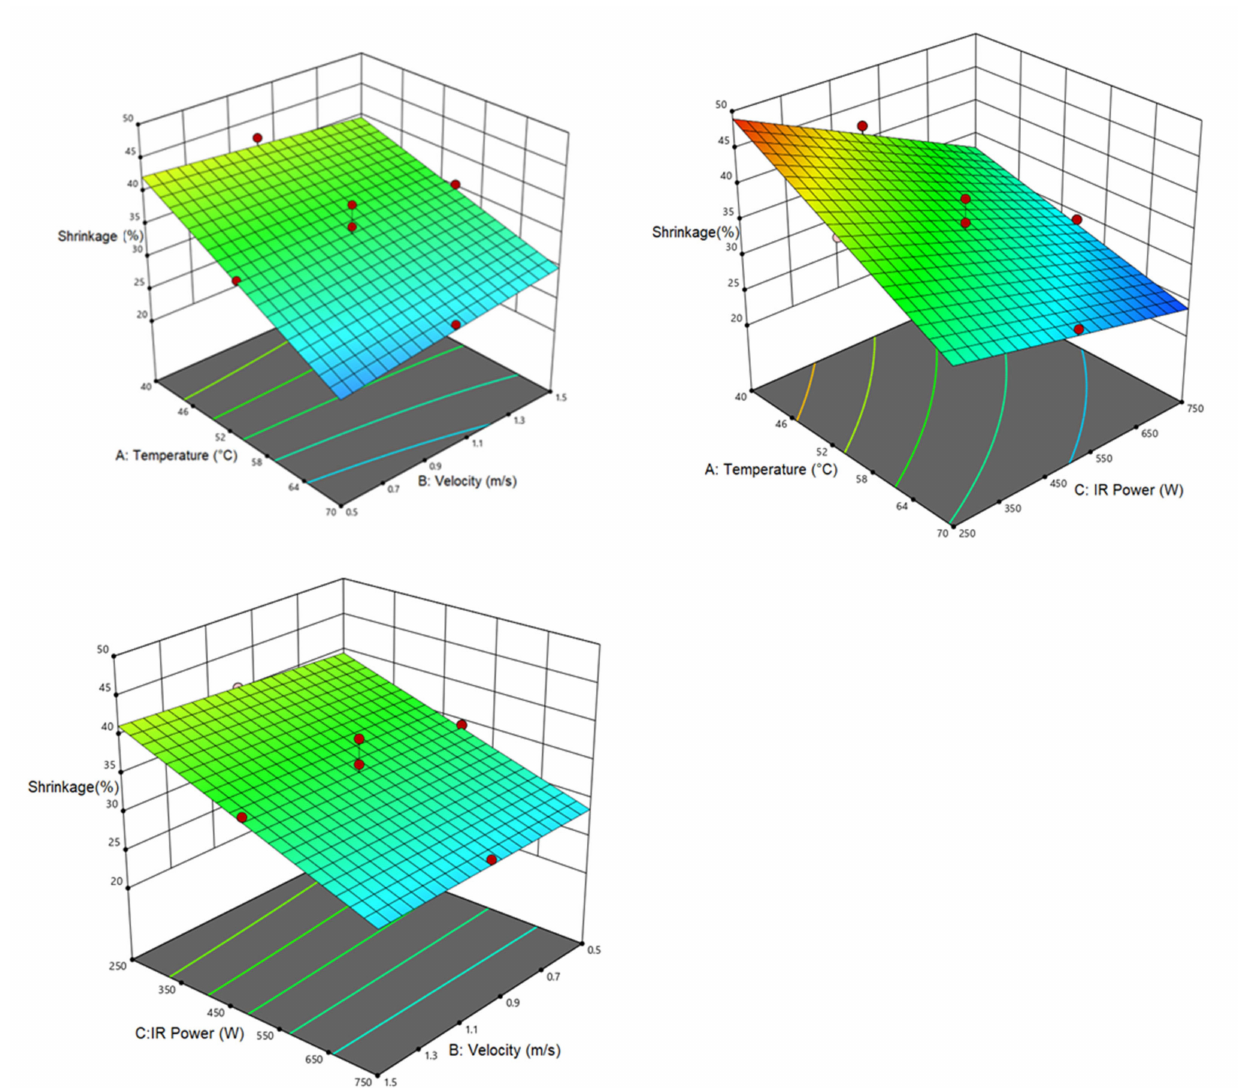
Figure 4. Interaction of air temperature/air velocity, air temperature/IR power, and IR power/air velocity on shrinkage of